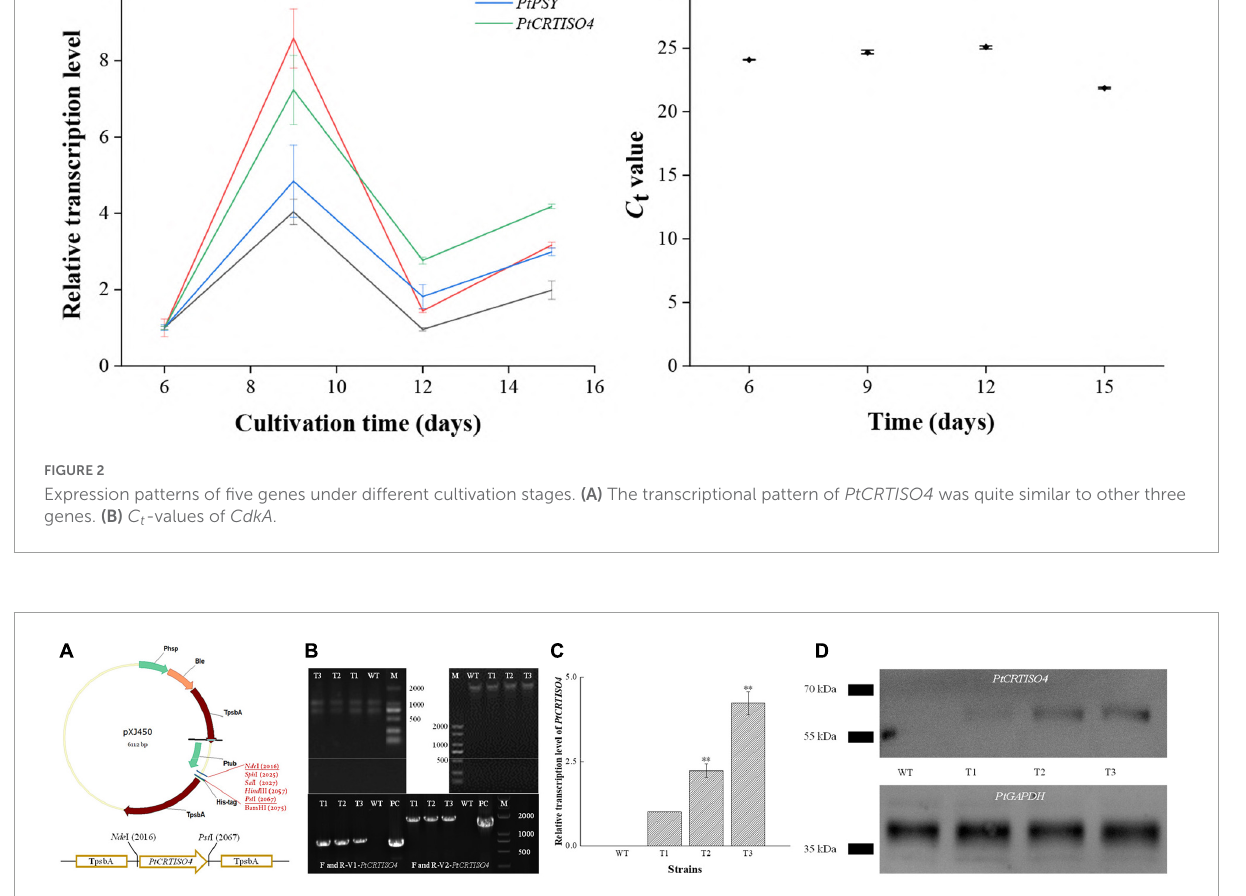
FIGURE3 Construction of recombinant vector and screening of positive transformant. (A) After being digested by Nde I and Pst I, PtCRTISO4 was inserted into pXJ450. (B) Genomic DNA and total RNA from transformants and of N . oceanica , and the polymerase chain reaction (PCR) results using primers of V1- PtCRTISO4 and V2- PtCRTISO4 based on gDNA and cDNA, respectively. M and PC indicate marker and positive control (recombinant plasmid), respectively. (C) Relative transcription levels of PtCRTISO4. (D) Western Blotting analysis using anti-His-tag antibody, PtGAPDH was used as the internal control. **Indicates a highly significant difference ( p <